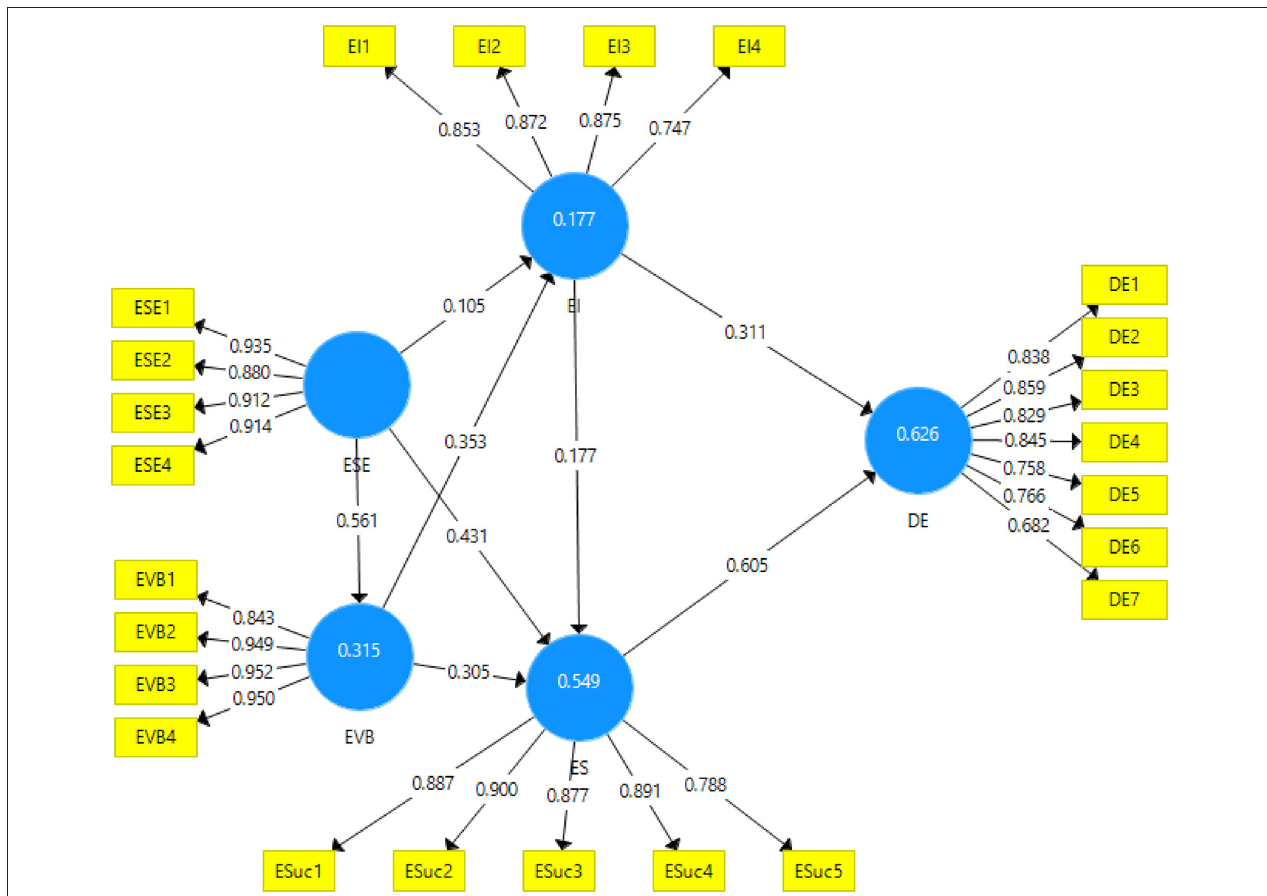
FIGURE 2 | Measurement model algorithm. ESE, Entrepreneurial Self-Efficacy; EVB, Expected Value Belief; EI, Entrepreneurial intention; ES, Entrepreneurial success; DE, Digital Economy.